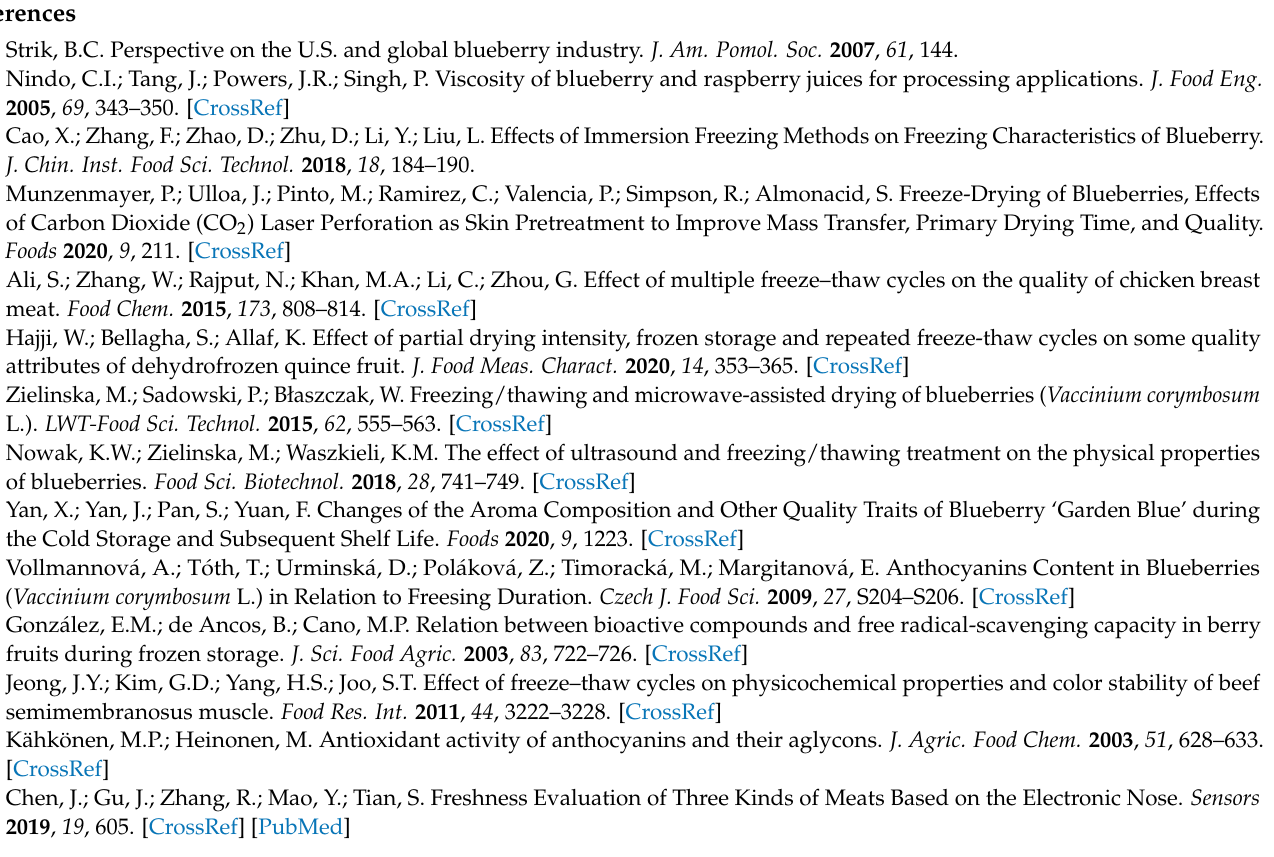
FT-2 and FT-3 represent the blueberry with freeze-thaw (FT) treatment once, twice and third times; Figure S2: Peak area in TIC assigned to each compound for (A) fresh juice, (B) freeze-thaw (FT) once, (C) FT twice and (D) FT third times; Figure S3: The correlation coefficient of a different model for the fitting of the hot-air drying curve of frozen blueberry. FT-1, FT-2 and FT-3 represent the blueberry with freeze-thaw (FT) treatment once, twice and third times; Table S1: Mathematical models applied to fit the drying curves; Table S2: The fitting models and statistical results for models. FT-1, FT-2 and FT-3 represent the blueberry with freeze-thaw (FT) treatment once, twice and third times; Table S3: Parameter of the Wang and Singh model for the correlation of hot-air drying curve of freeze-thaw (FT) treated blueberry fruit at 60 ◦ C. FT-1, FT-2 and FT-3 represent the sample with FT treatment once, twice and third